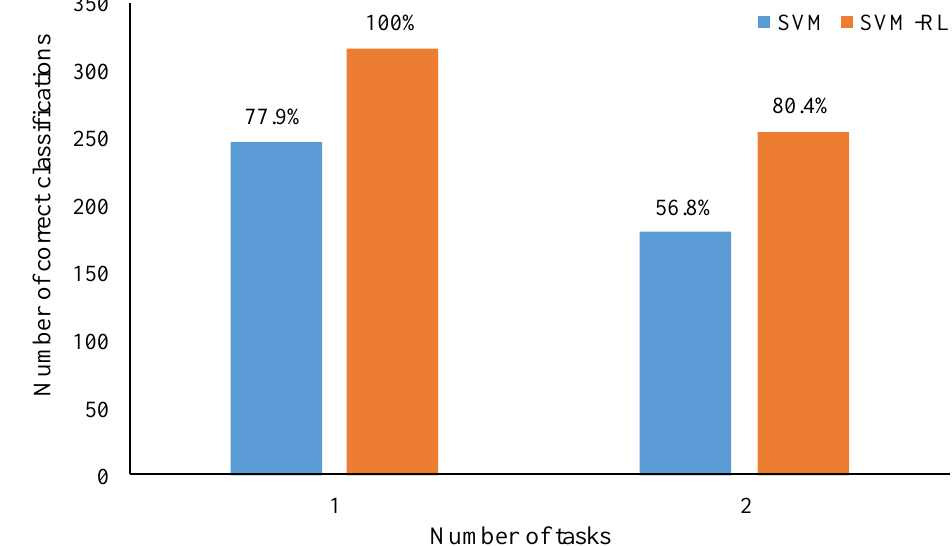
Figure 2. Comparison of classification accuracy of steelmaking problem models.